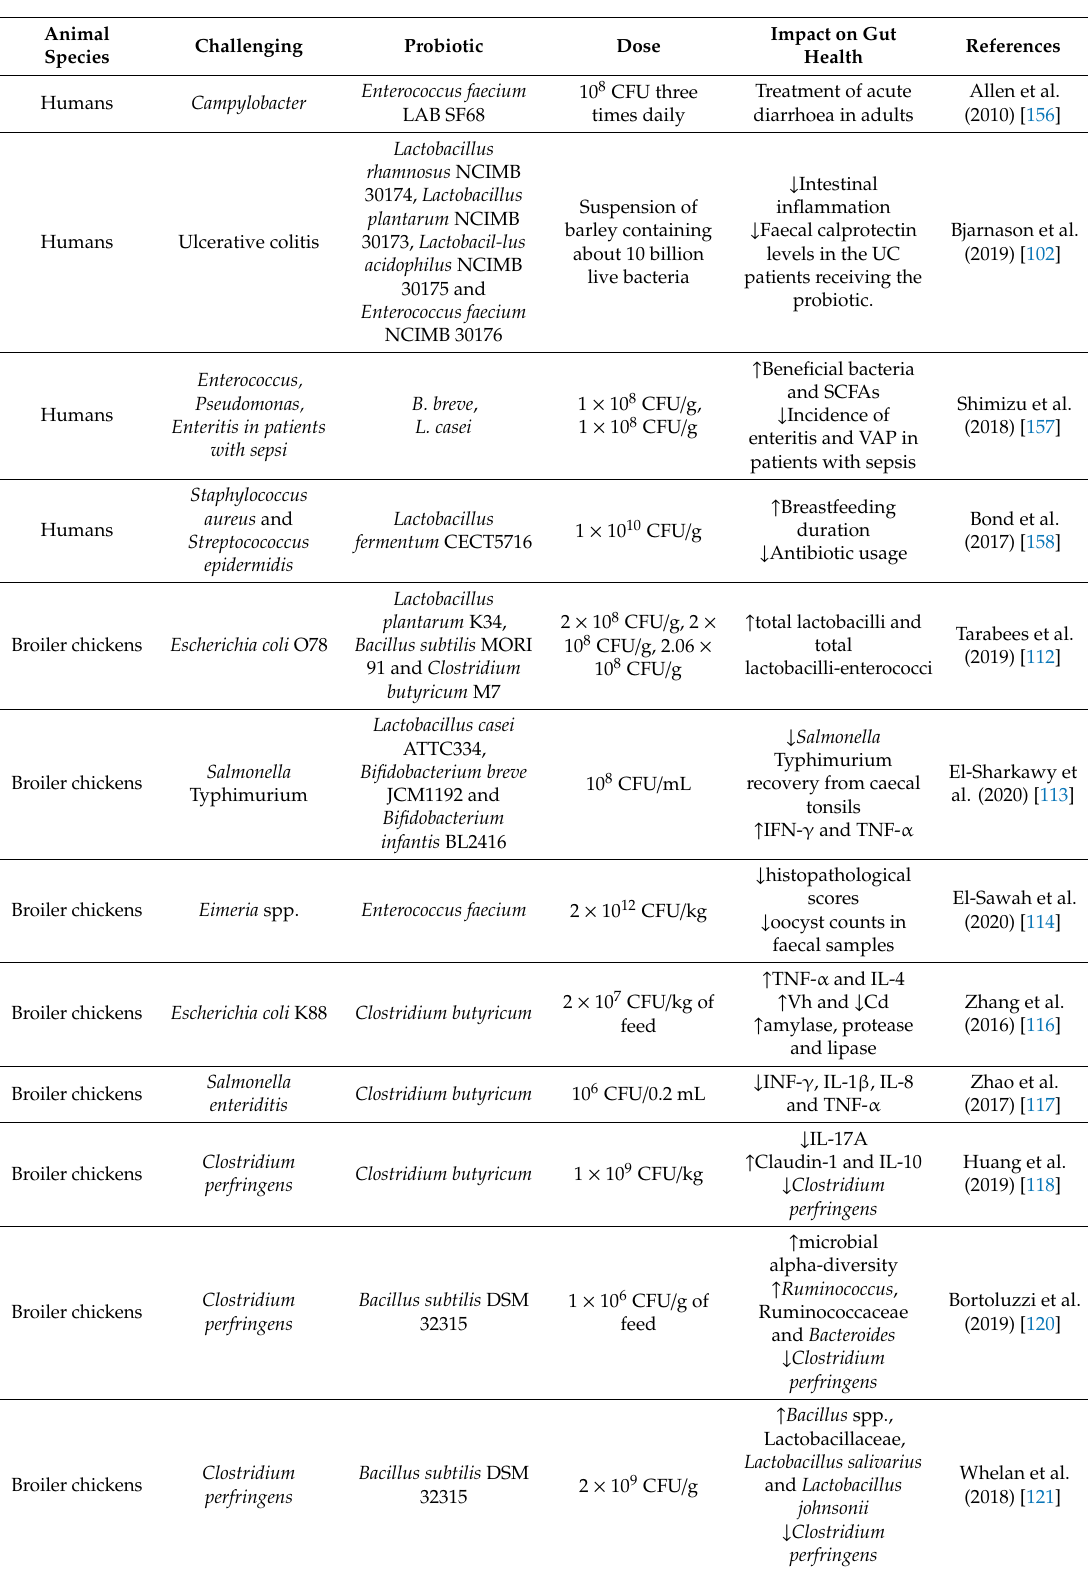
Table 1. Impact of probiotics on gastrointestinal health: main experimental studies. Animal